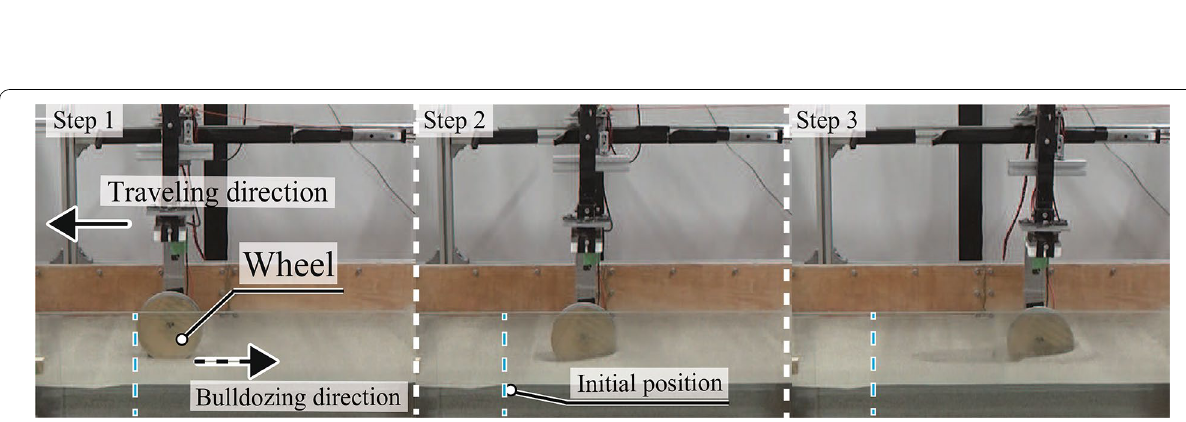
Fig. 9 Actual image of the wheel towing experiment. Diameter 0.17 m; width 0.04 m; mass 2.5